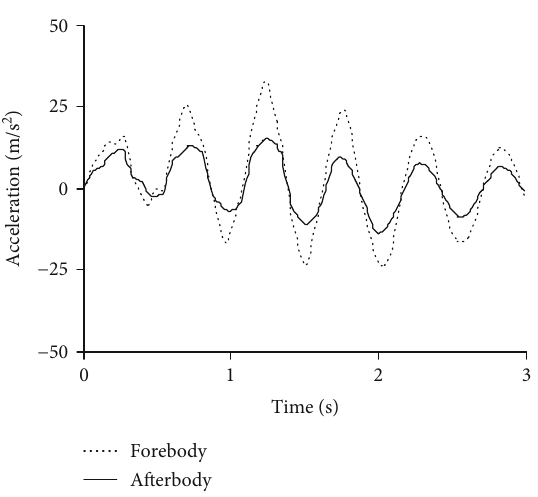
Figure 13: Transient response of acceleration at center of gravity of engines under repeated waves.